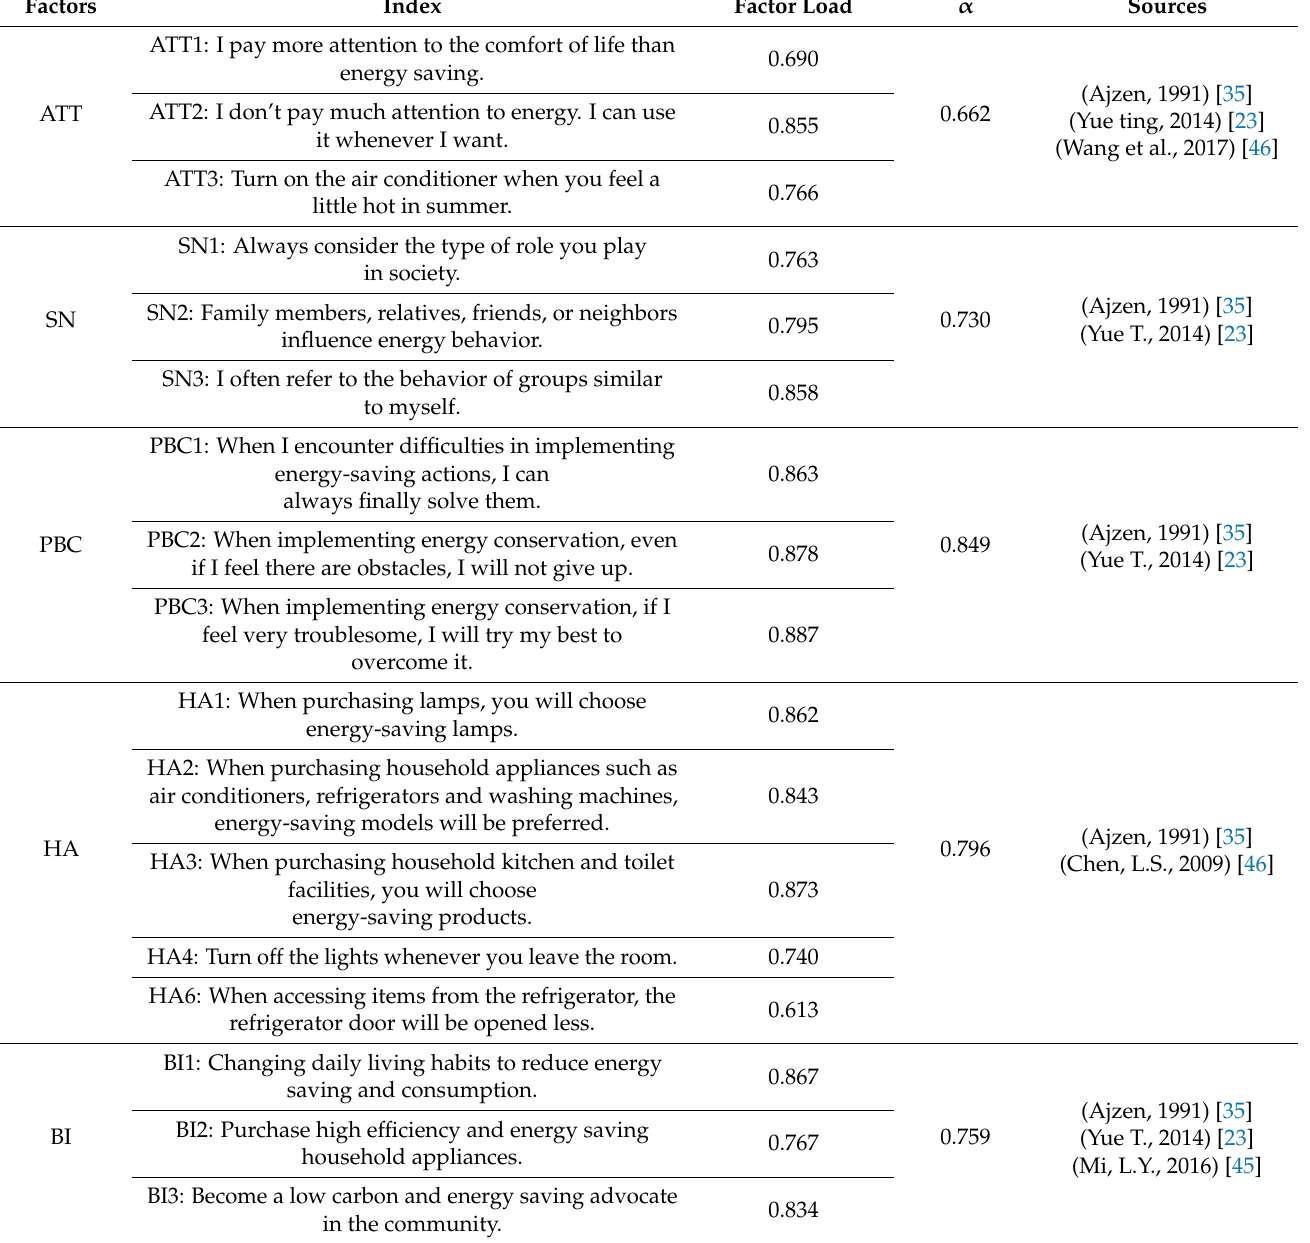
Table 3. Results of reliability and validity